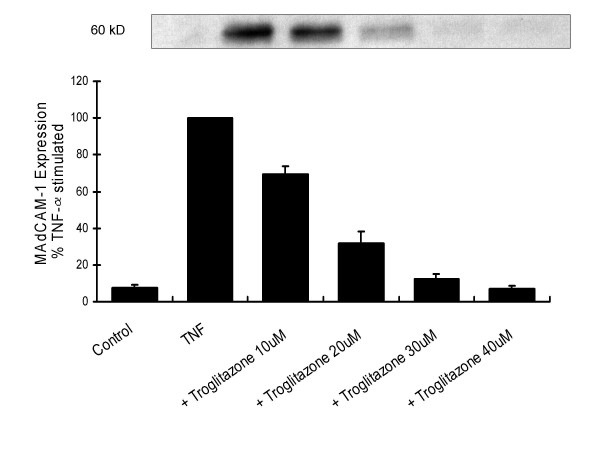
TNF-α induced MAdCAM-1 protein expression is reduced by troglitazone, a PPAR-γ ligand. TNF-α (1 ng/ml, 24 h) induced MAdCAM-1 expression was dose dependently blocked by the PPAR-γ ligand, troglitazone at concentrations between 10 to 40 μM (Fig. 2).